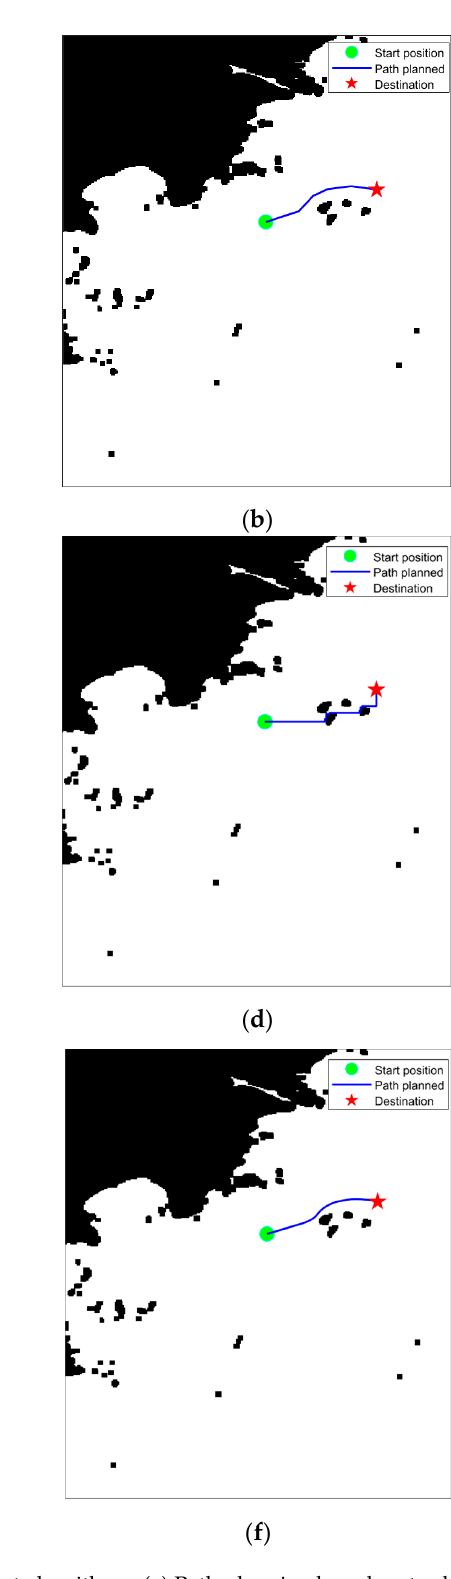
Figure 15. Comparison of path planning results under different algorithms. ( a ) Path planning based on traditional DQN; ( b ) Path planning based on Q-learning algorithm; ( c ) Path planning based on DDPG algorithm; ( d ) Path planning based on A* algorithm; ( e ) Path planning based on BUG2 algorithm; ( f ) Path planning based on APF algorithm.